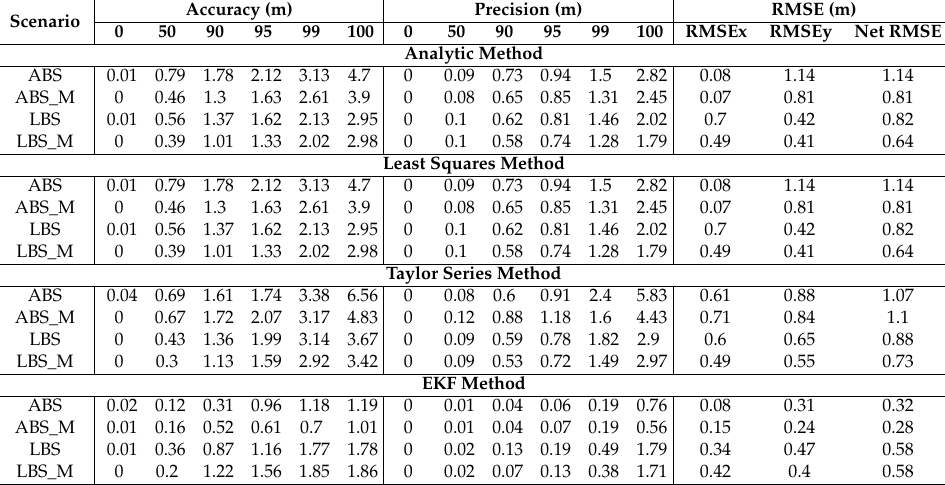
Table 4. Performance comparison of the localization algorithms for the metrics accuracy, precision, and RMSE. All localization algorithms are compared for both atrium and lab scenarios, with human body interference, and with or without NLOS mitigation algorithm.